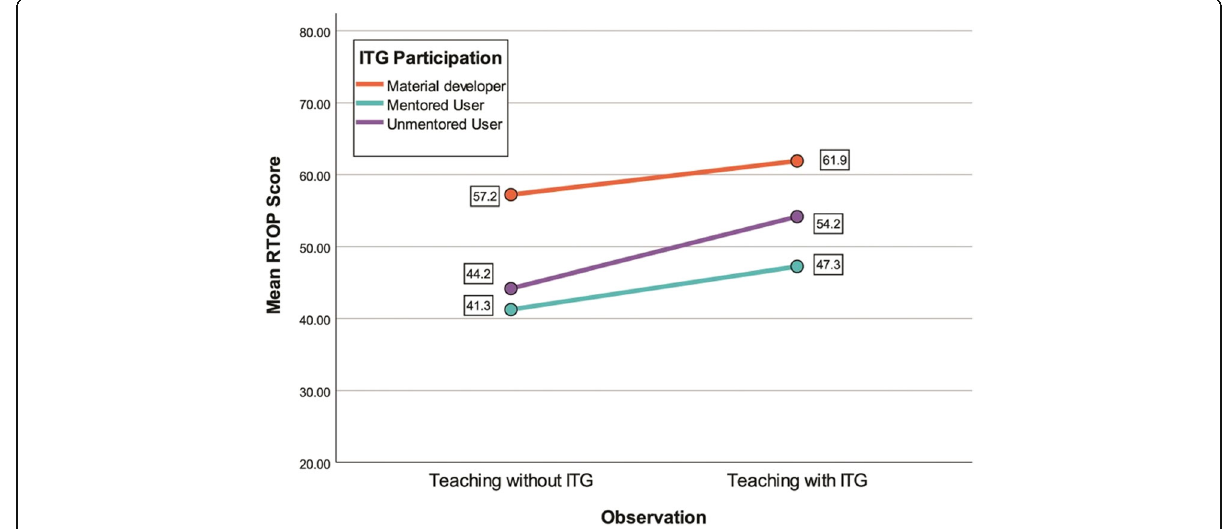
Fig. 8 Mean RTOP scores for paired instructors ’ ITG and non-ITG observations, separated by instructors ’ participation in ITG